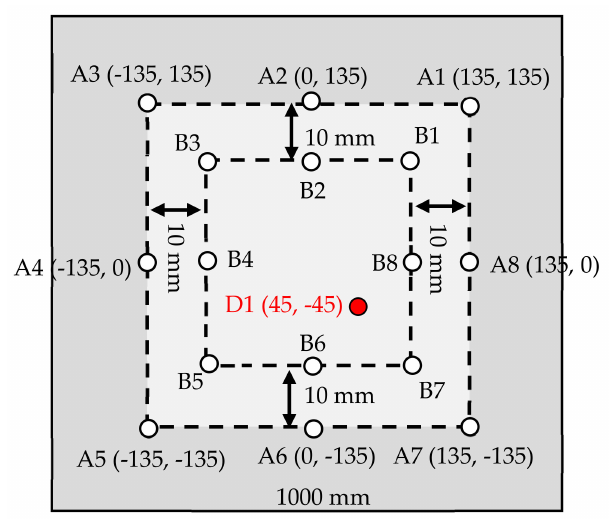
Figure 4. Square arrangement of piezoelectric (lead zirconate titanate, PZT) transducers on a damaged plate.